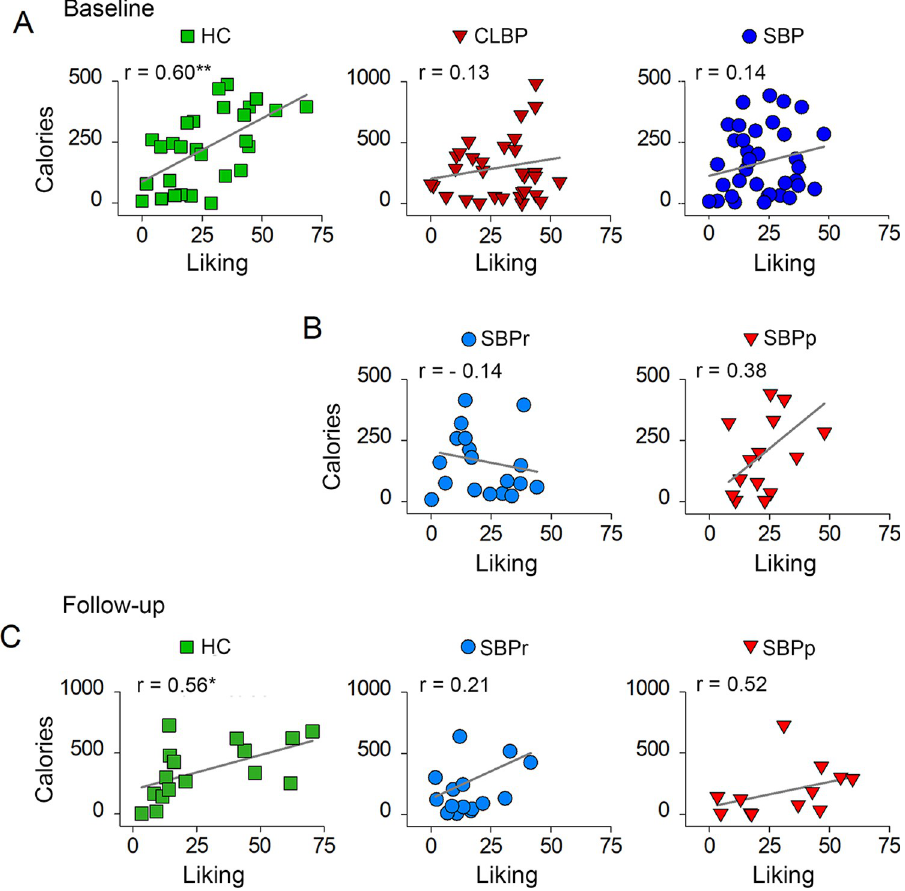
Fig 5. Regression plots of the most preferred pudding liking reported during session 1 and the caloric ingestion from that pudding during session 2 at baseline (A-B) and at follow-up (C). (A) Regression plots for SBP (n = 37), CLBP (n = 32) and healthy control subjects (n = 28) at baseline; ( B ) Regression plots for SBPr (n = 17) and SBPp (n = 14) groups at baseline; ( C ) Regression plots for SBPr (n = 15), SBPp (n = 12) and HC (n = 15) subjects at follow-up. �� , p < 0.01, � , p <